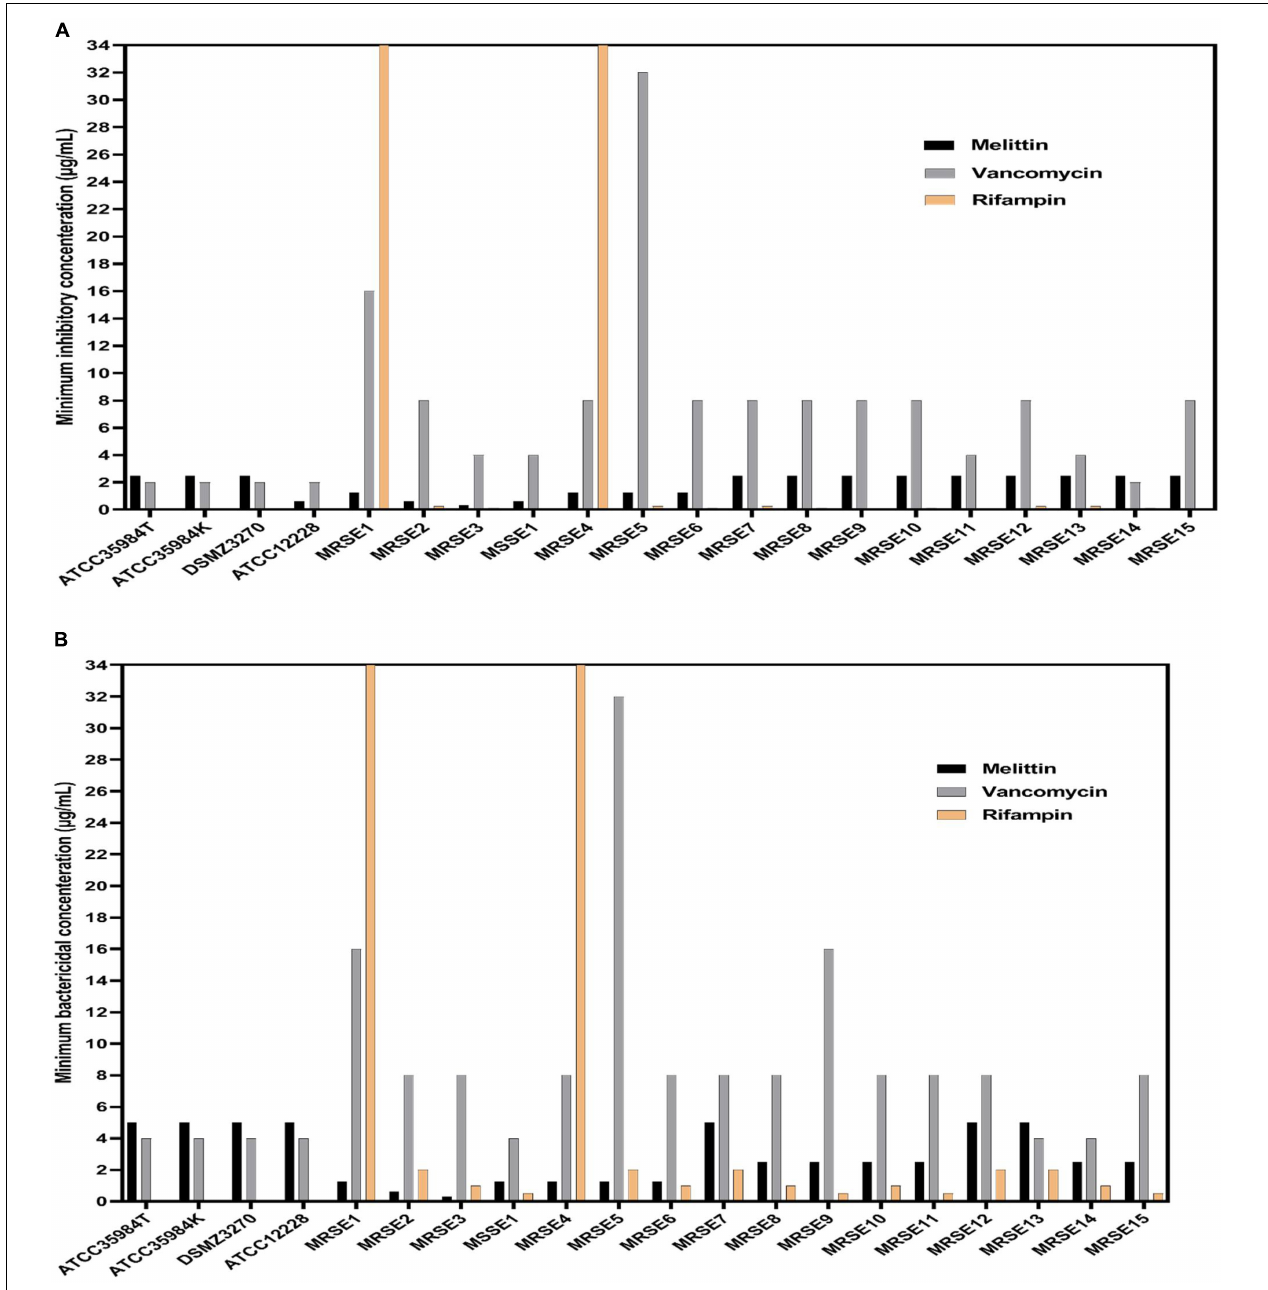
FIGURE 1 | Minimum inhibitory concentration (MIC), minimum bactericidal concentration (MBC) values for vancomycin, rifampin, and melittin against Staphylococcus epidermidis . In panel (A) , MIC value of rifampin was higher than 1,024 µ g/ml for MRSE 1 and MRSE 4 but was not shown due to the space of the graph. In (B) , MBC value of rifampin was higher than 1,024 µ g/ml for MRSE 1 and MRSE 4 but was not shown due to the space of the graph. ATCC, American Type Culture Collection; DSMZ, Deutsche Sammlung von Mikroorganismen und Zellkulturen, MRSE, methicillin-resistant S. epidermidis ; MSSE, methicillin sensitive S. epidermidis .